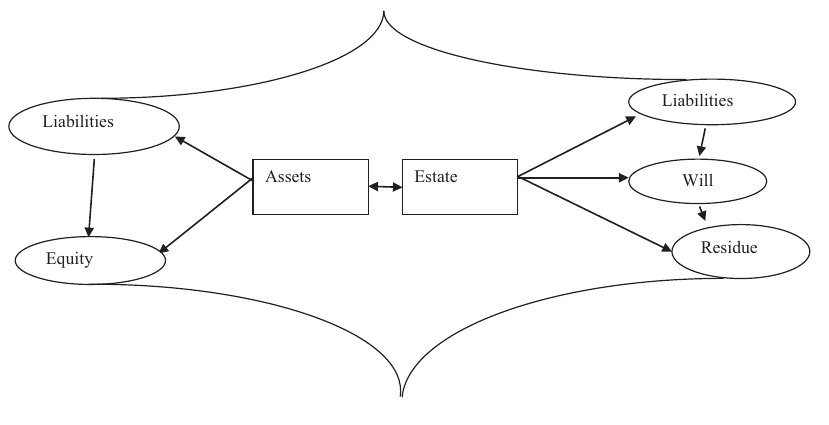
Figure 2. Comparison